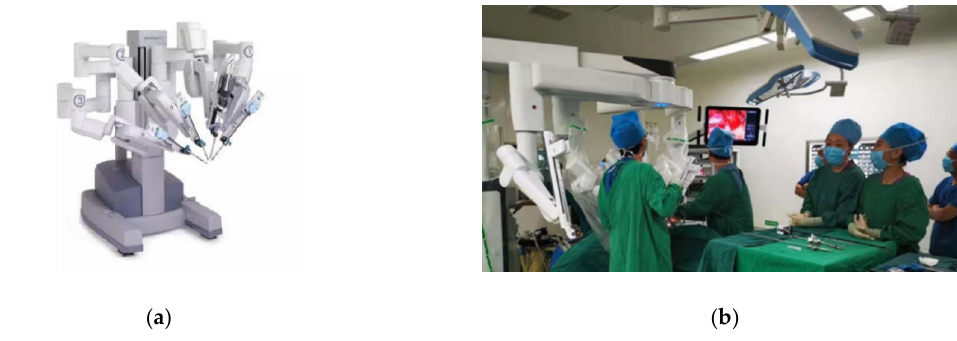
Figure 1. Pictures showing the Da Vinci robot. ( a ) The Da Vinci Xi robot, ( b ) the robot being used for interventional surgery.